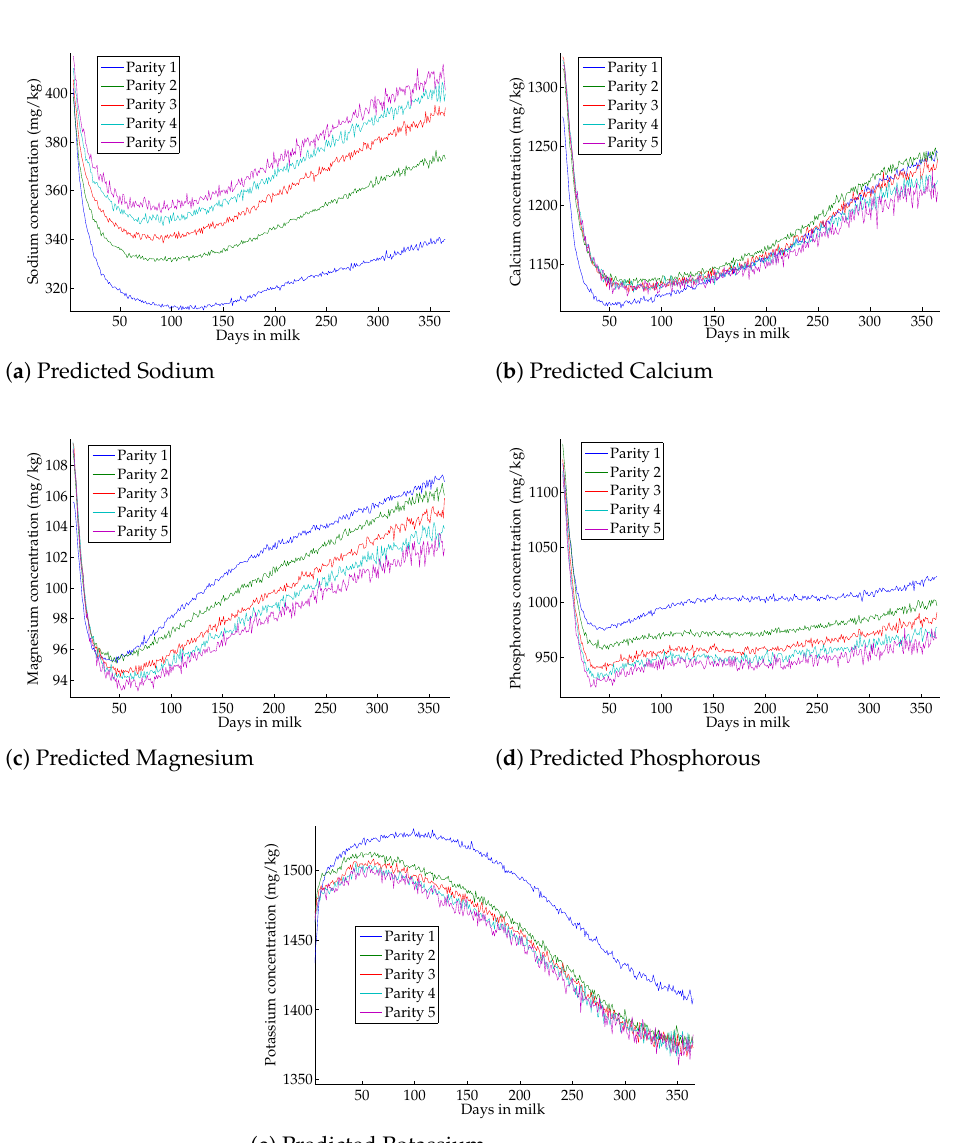
Figure 2. Evolution of the predicted mineral concentration through the days in milk and parity. ( a ) Predicted Sodium ( b ) Predicted Calcium ( c ) Predicted Magnesium ( d ) Predicted Phosphorous ( e ) Predicted